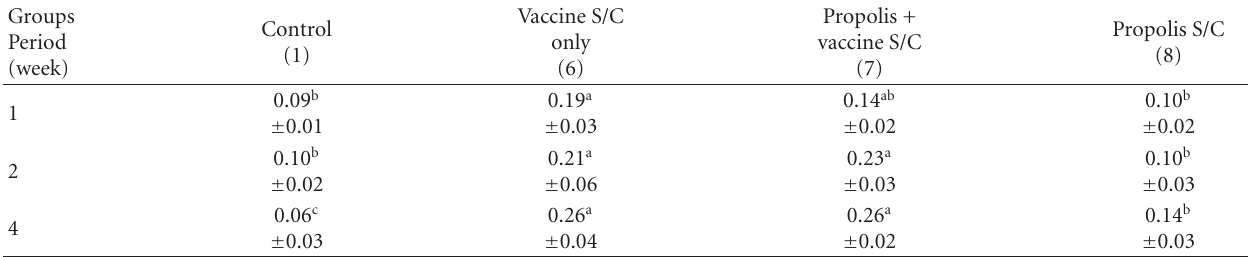
Table 4: Lymphocyte proliferation assay (BrdU) in di ff erent experimental groups of rabbits received propolis and vaccine treatments for six weeks (mean ±